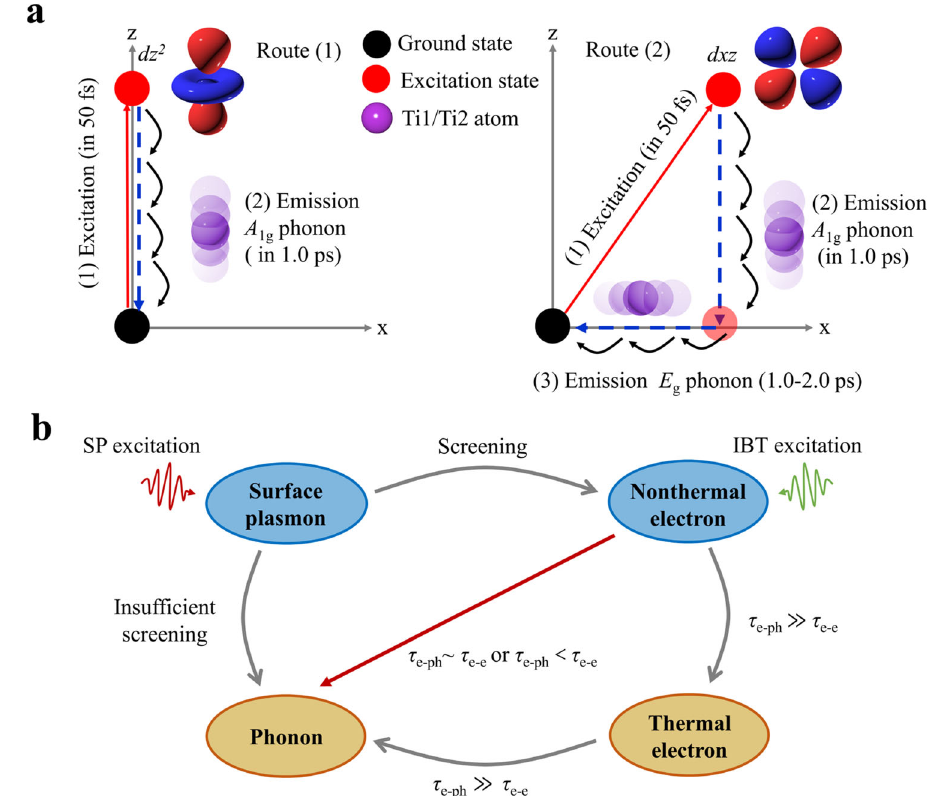
Fig. 5 | Energy transfer pathways. a The symmetry-dependent electron-phonon coupling: for route 1, the electron is excited into dz 2 orbit, then it couples with A 1g mode;forroute2,theelectronisexcitedinto dxz orbit,thenitcoupleswith A 1g and E g modes. The Shadings of purple ball indicate the directions of atomic vibration. b The energy transfer channels from photon to phonon. The τ e-ph is the time constant of the electron-phonon coupling and the τ e-e is the time constant of the electron-electronscattering.ForaSPmaterialafterabsorbingphotonstoexcitethe SP, in a case of a strong screening effect of the nucleus by high free electrons